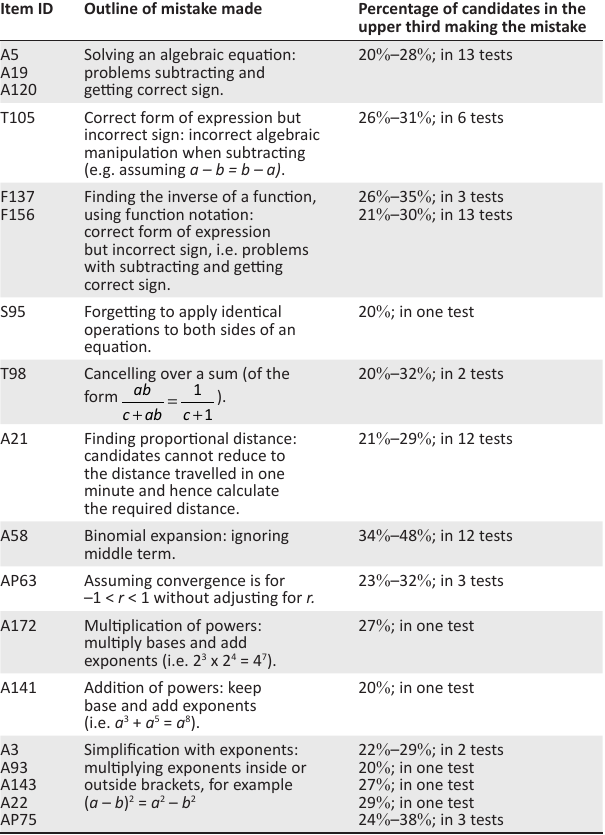
TABLE 4: Algebraic processing. Item ID Outline of mistake